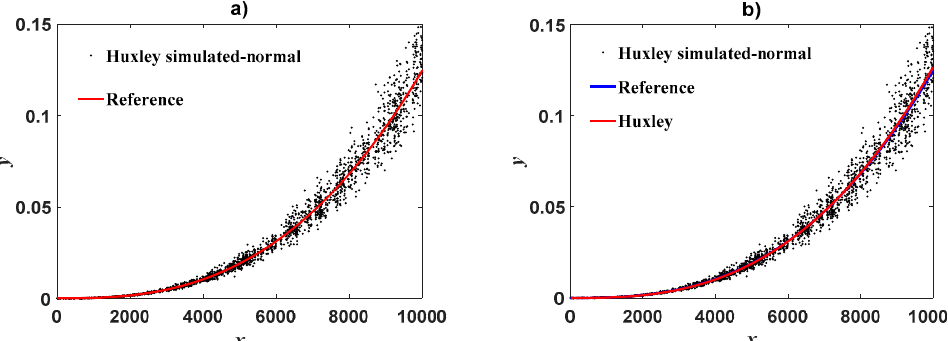
Figure A1. Huxley’s model of simple allometry fitted by DNLR on simulated lognormally distributed data. Panel ( a ) displays spread of y k ( i ) ( (cid:15) ) replicates about the reference curve y i = p 0 exp ( q 0 lnx i ) . Panel ( b ) compares reference curve and mean response y = β x α fitted in direct arithmetical space by means of non-linear regression.